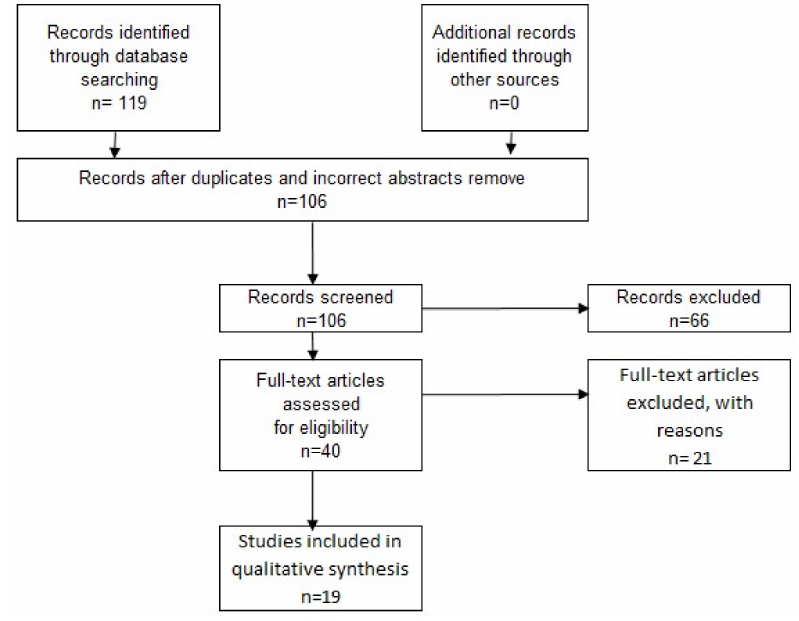
Figure 1. Summary review